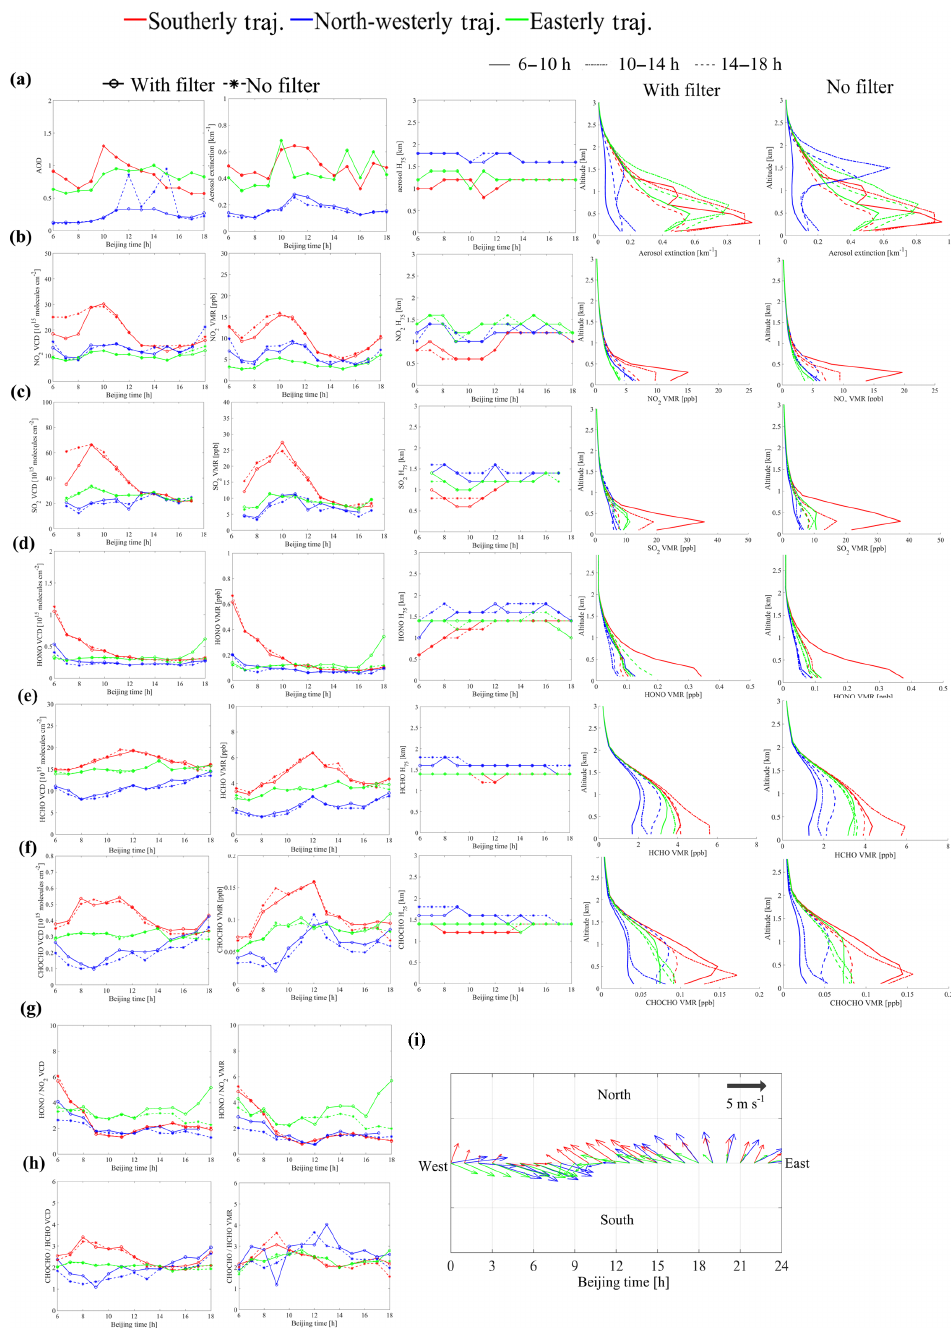
Figure 12. Averaged MAX-DOAS results for the three groups of days with different dominant directions of night-time trajectories (different colours). In the left two columns of panels (a) to (f) , the diurnal variation in AOD, trace gas VCDs, near-surface aerosol extinction and near-surface trace gas VMRs are shown (circles and stars indicate the filtered and unfiltered results based on the deviations of measured and modelled dSCD in the profile inversion). In the middle column of subfigures, the diurnal variations in H 75 of retrieved profiles are shown. In the right two columns of subfigures the corresponding averaged profiles for three periods (different line styles) are shown. Panels (g) , (h) and (i) show the averaged ratios of HONO to NO 2 VCD and near-surface VMRs, the averaged ratios of CHOCHO to HCHO VCDs and near-surface VMRs, and the averaged diurnal variation in the local wind fields, respectively. In general, pollutant levels are the highest with winds out of the south and east where major sources reside and lowest with winds out of the north or north-west being generally behind cold fronts. HONO / NO 2 ratios are the highest for winds from the east, where the agricultural activity is, and CHOCHO / HCHO ratios are the highest for back trajectories out of the south, indicating the dominance of petrochemical activity